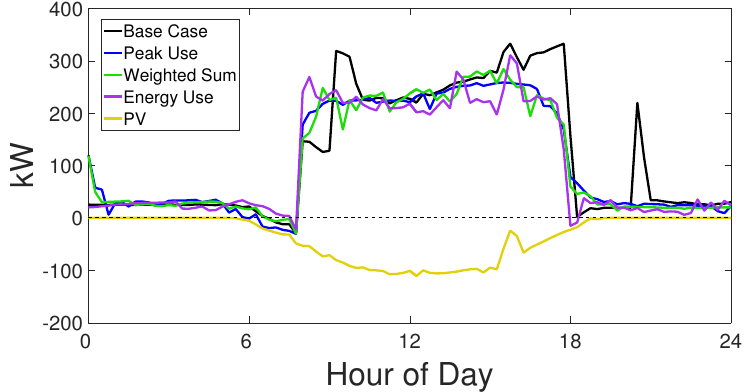
Figure 10. A comparison between the total building load profiles obtained under the rules-based control scheme (black line), the Peak Demand MPC (blue line), the Net Energy Use MPC (purple line), the Weighted Sum MPC (green line), all with perfect solar forecasting and a horizon length of 5 hours, for the “high solar” day. The solar power generation profile is indicated by the yellow